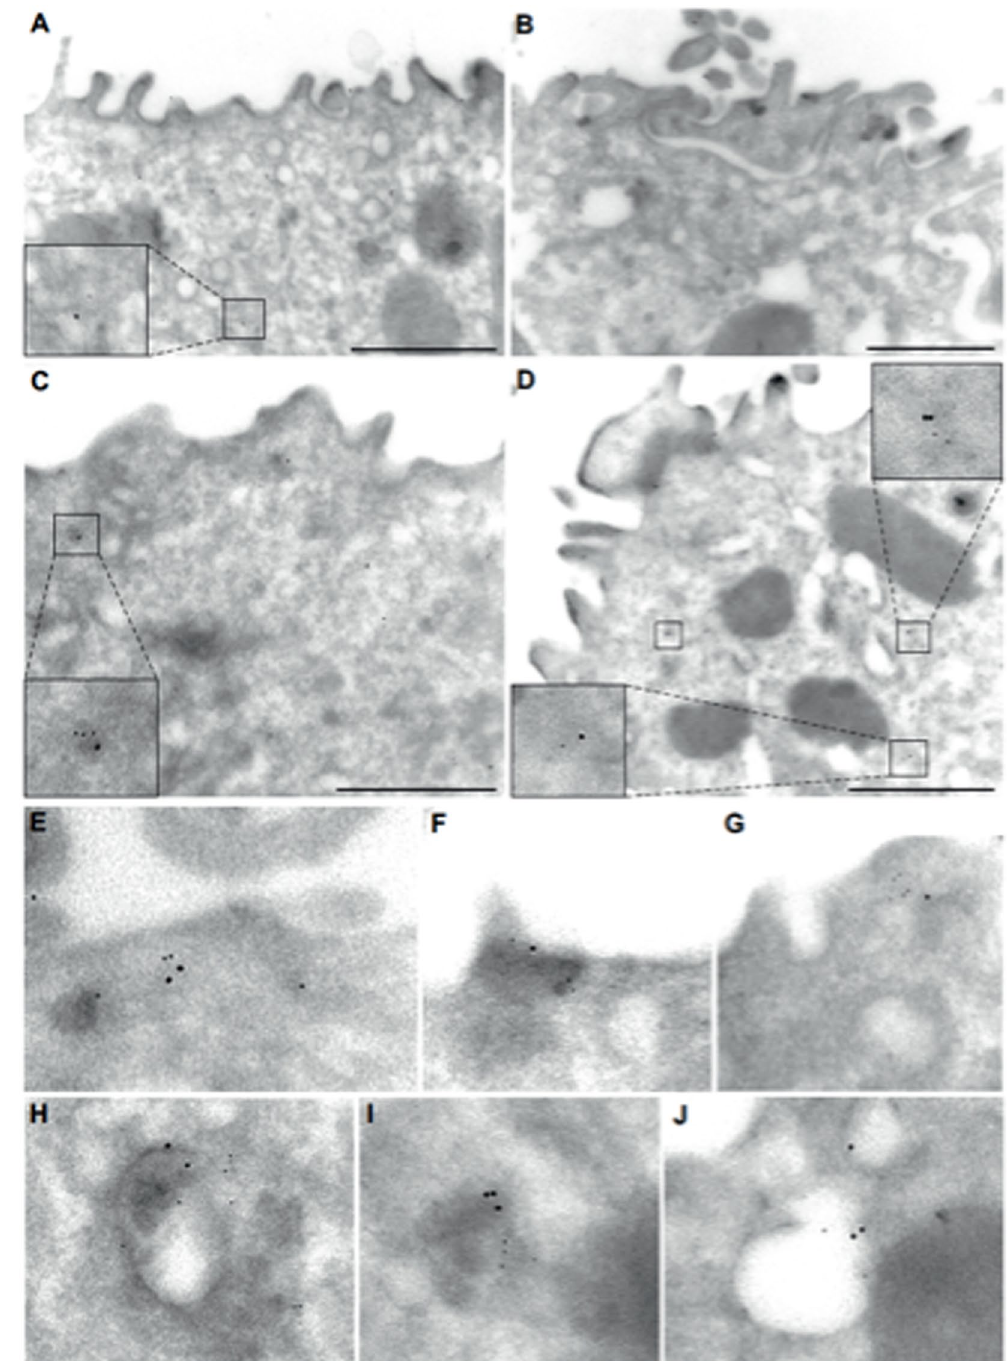
Figure 1. Electron microscopy detects close proximity of NCC and ENaC in murine kidney cortex after aldosterone treatment. Immunogold labeling of NCC (12 nm particles) and γ ENaC (6 nm particles) in mouse DCT2 of ( A , B ) vehicle (25% DMSO in saline) and ( C – J ) Aldo-treated kidney cortex. The inserts ( A – D ) show a magnified view of closely associated NCC and γ ENaC. Figures E – J are magnified views of increased NCC- γ ENaC intracellular colocalization, close to the cell surface ( E – G ) and in intracellular vesicles ( H – J ). Scale bar = 1 μ